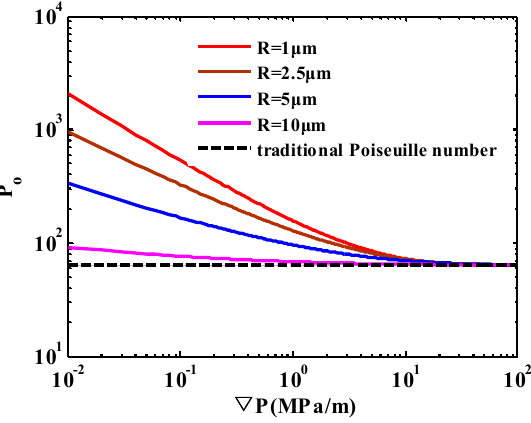
Figure 14. The relationship of P o versus ∇ P.